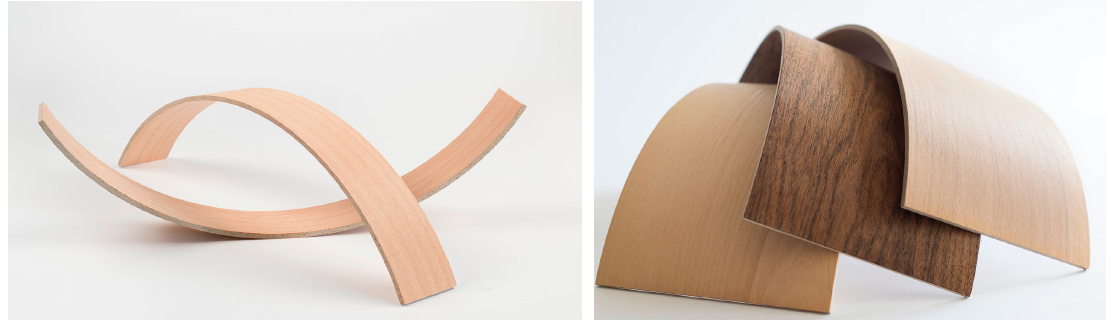
Figure 2. Double-sided veneering of flexible biocomposite defines a stable curved shape. © BioMat/ITKE – University of Stuttgart.